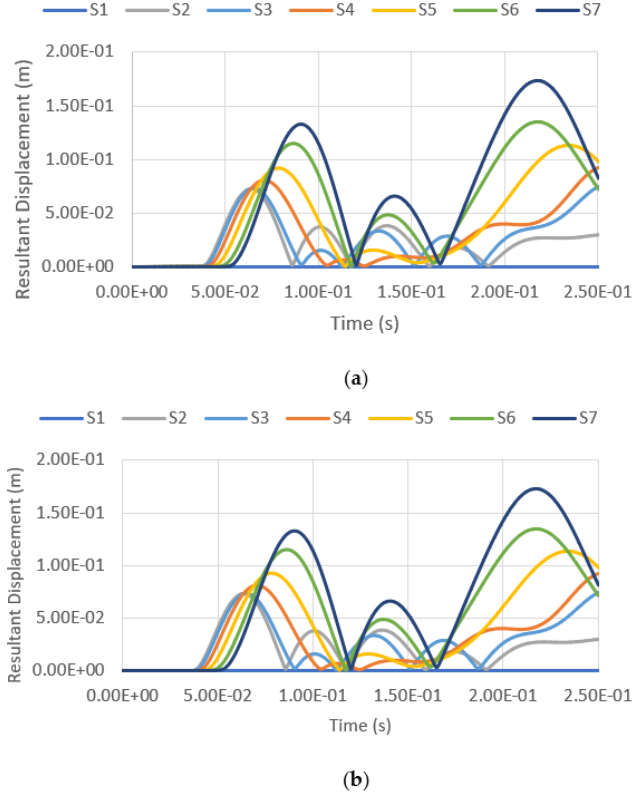
Figure 17. Resultant displacement versus time under blast intensity of 380 kg TNT equivalent mass 25 m away, ( a ) 100% fill and ( b ) 0% fill.